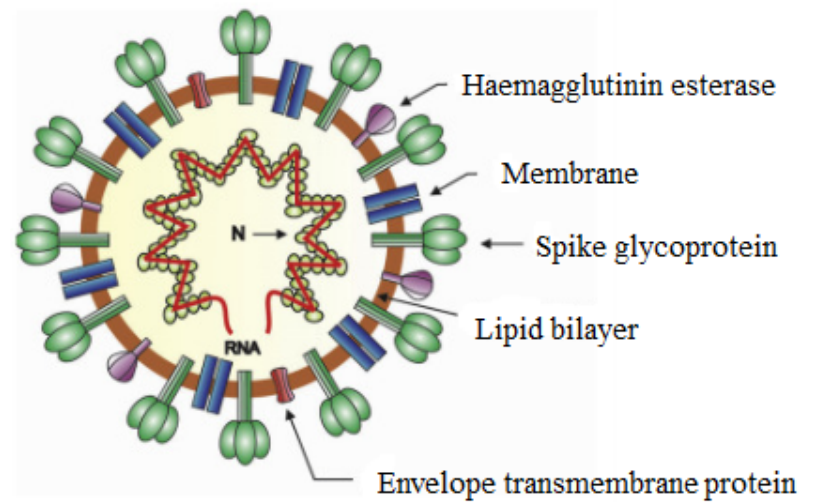
Figure 7. A structure design of coronavirus particle. Reproduced with permission from [100].